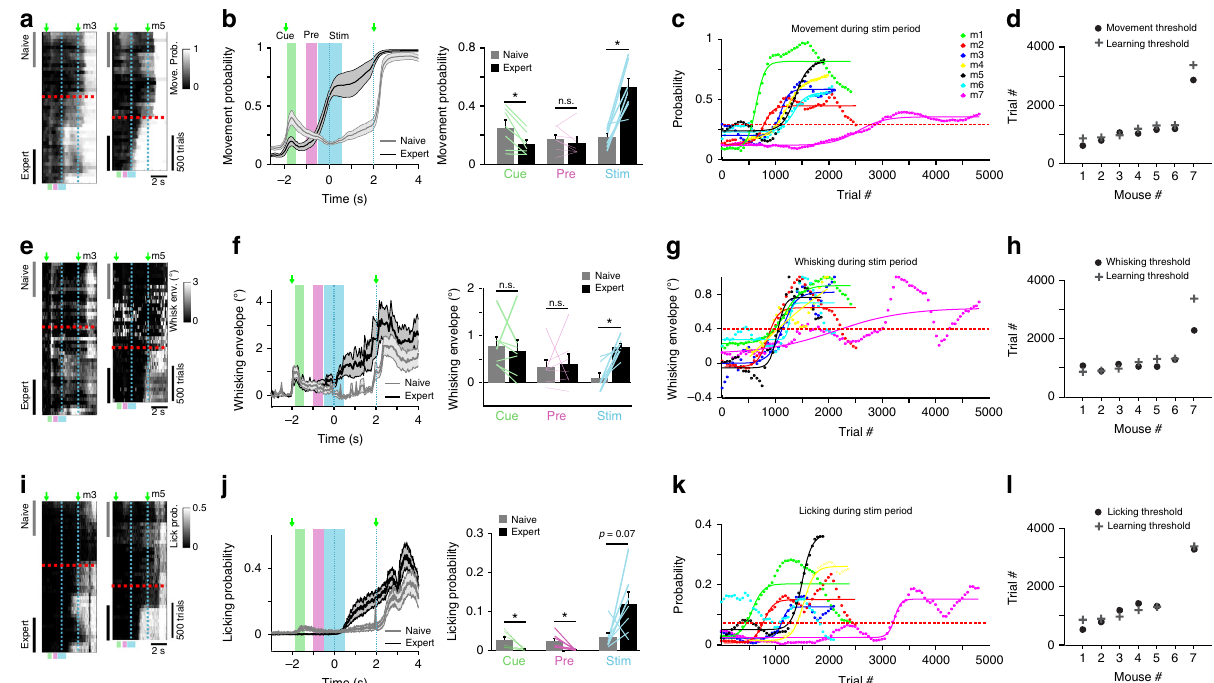
Fig. 2 Motor parameters during the stim-period are associated with learning. a Movement probability for go-trials of two example mice plotted as heat maps along the two temporal dimensions (trial dimension on x -axis; learning dimension on y -axis; 50-trial bins along learning dimension). Horizontal red dashed line indicates learning threshold. Vertical cyan dashed lines demarcate ‘ texture in ’ period. Naïve and expert phases were analyzed in the 500 fi rst and last trials, respectively. b Left: Time course of movement probability averaged across all 7 mice during go-trials for naïve phase (gray trace) and expert phase (black trace), respectively. Error shading indicates s.e.m. Green arrows indicate stimulus and response cue. Right: Mean movement probability (±s.e.m) in cue-, pre-, and stim-period for naïve and expert phase. n = 7 mice; Lines depict individual mice. * p < 0.05, n.s. not signi fi cant, Wilcoxon signed-rank test. c Movement probability during stim-period across learning for all mice. Each curve was fi tted with a sigmoid function. Dashed red line indicates movement threshold ( = 0.3). d Movement threshold for all mice (circles). For comparison the learning thresholds from Fig. 1g are shown (crosses). e – h Same plots